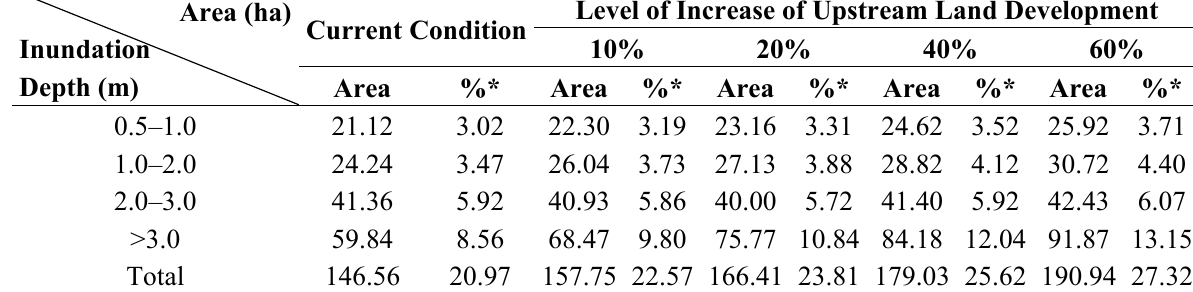
Table 7. Effects of different levels of upstream development on the percentage of inundation area of the urban planning zone (200-year return